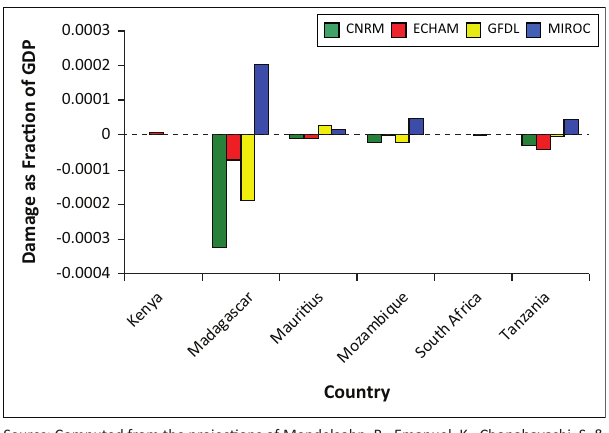
FIGURE 3: Projected annual hurricane damage by country.